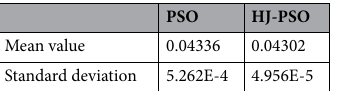
Table 8. Comparison of optimization results.